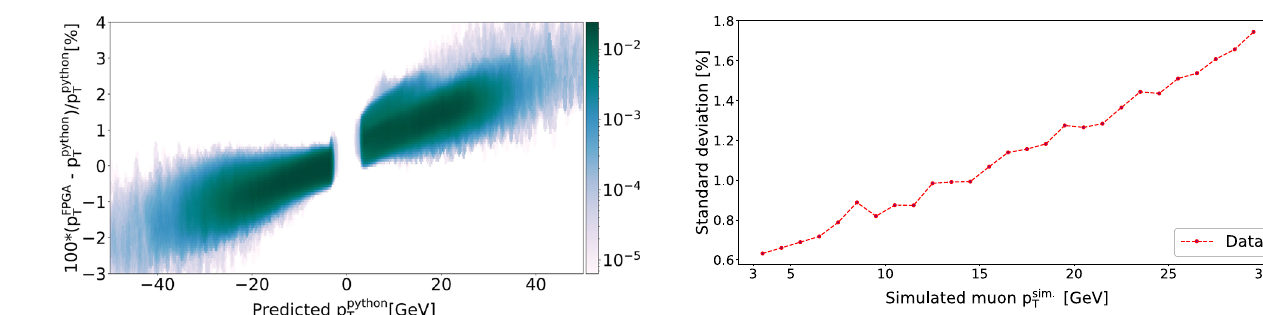
Fig. 15 Relative differences between p T values computed by the soft- ware and FPGA plotted as a function of p T predicted by the software